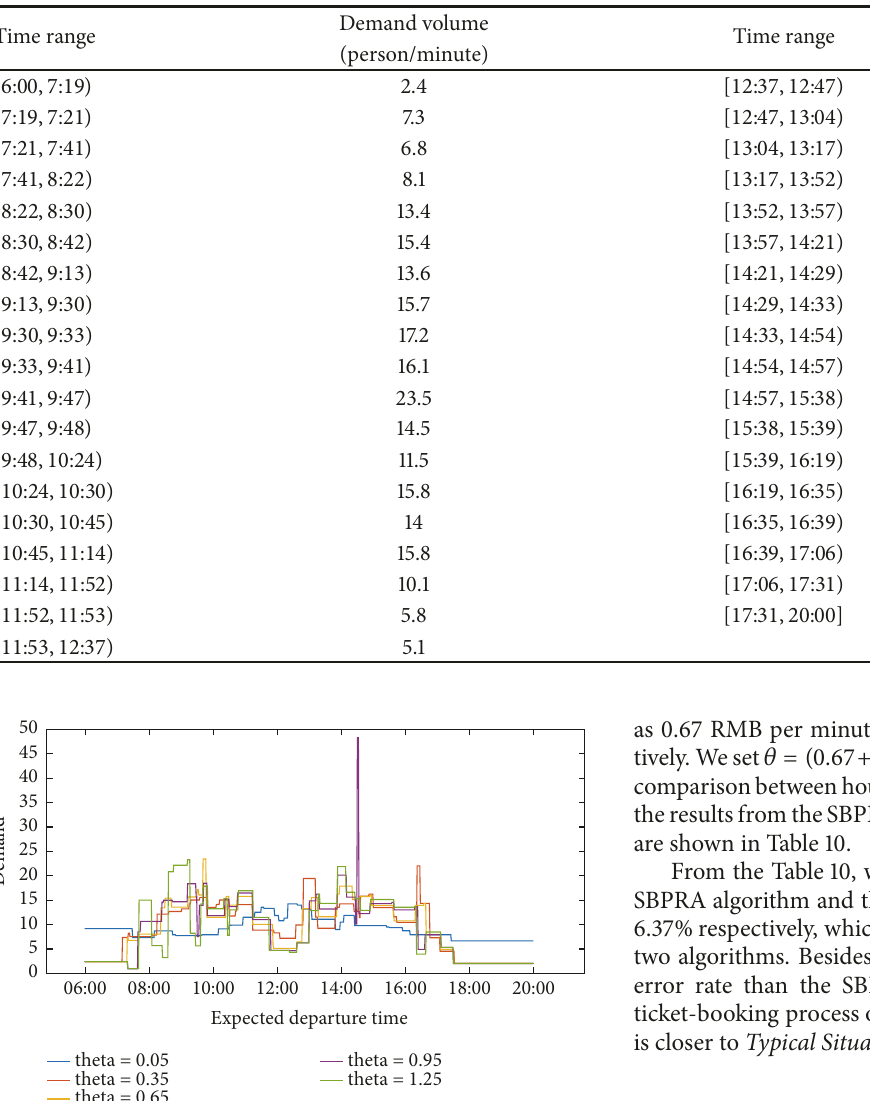
Figure 16: The time-varying demand distributions from MBPRA algorithm with different 𝜃